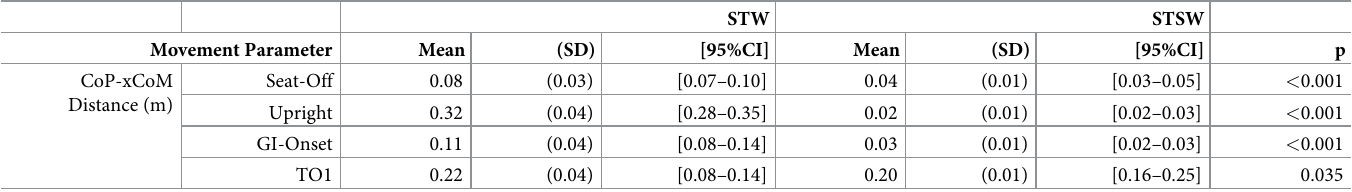
Table 4. Mean (SD) [95%CI] comparison for CoP-xCoM horizontal distance at key movement events between STW and STSW.